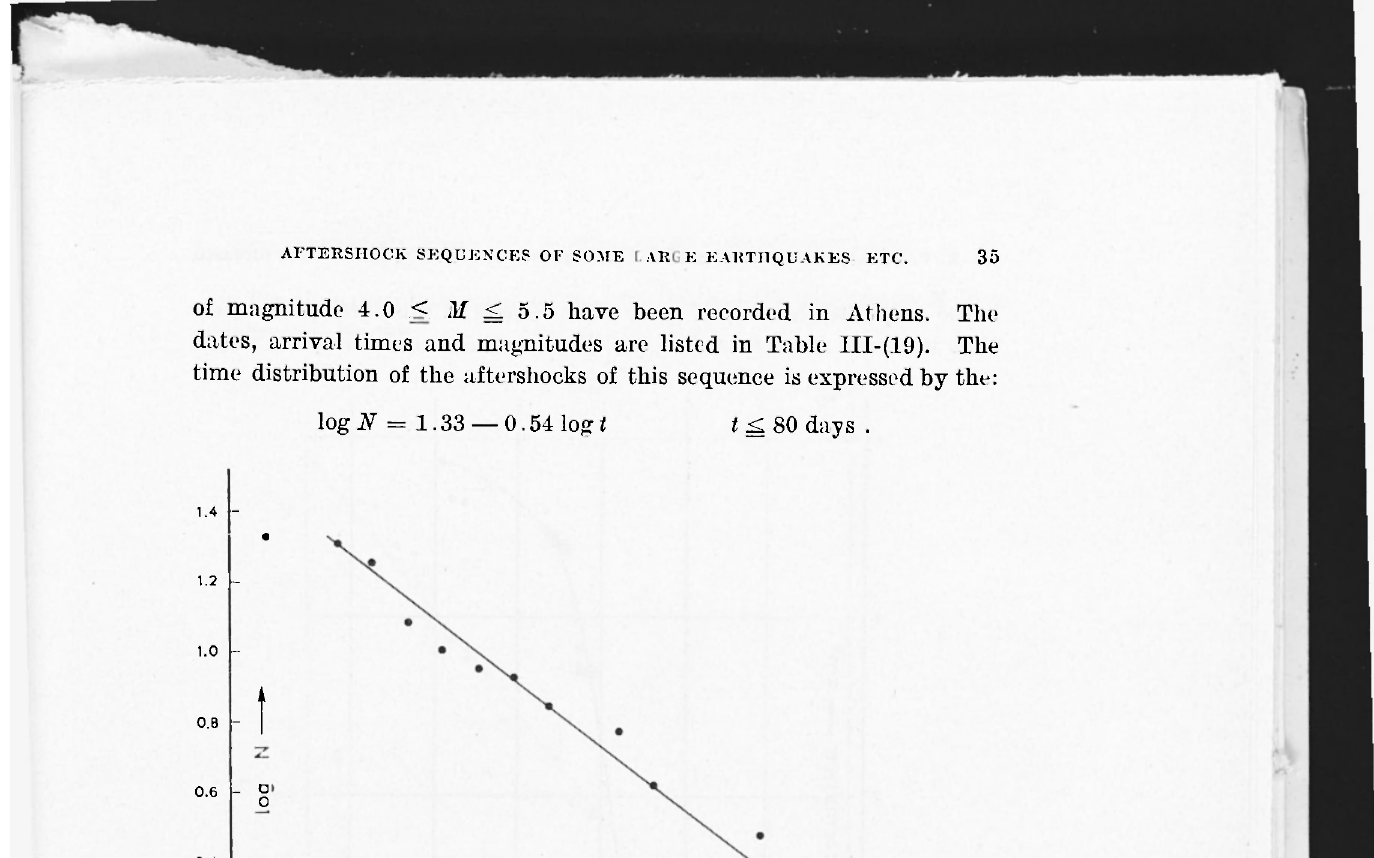
Fig. 23 - Distribution of the Magnitudes of the aftershocks of the Lemnos Earthquake of August 3,